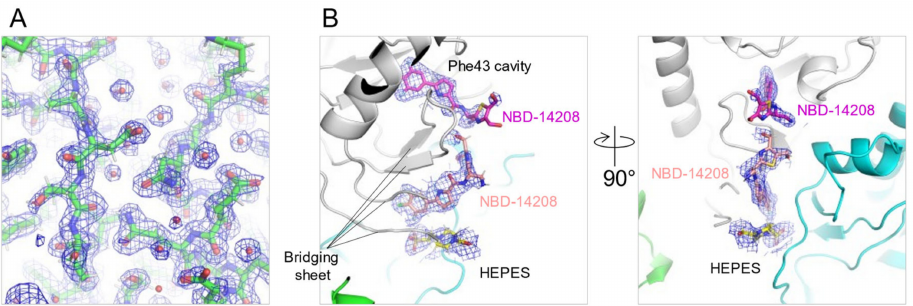
Figure 3. Electron density of NBD-14204- or NBD-14208-bound gp120 structures. ( A ) The 2Fo-Fc elec- tron density map of NBD-14204 bound gp120 contoured at 1 σ . ( B ) Additional NBD-14208 compound was found under the bridging sheet region. Green and cyan molecules represent neighboring gp120s found in the crystal lattice. Table 3. Data collection and refinement